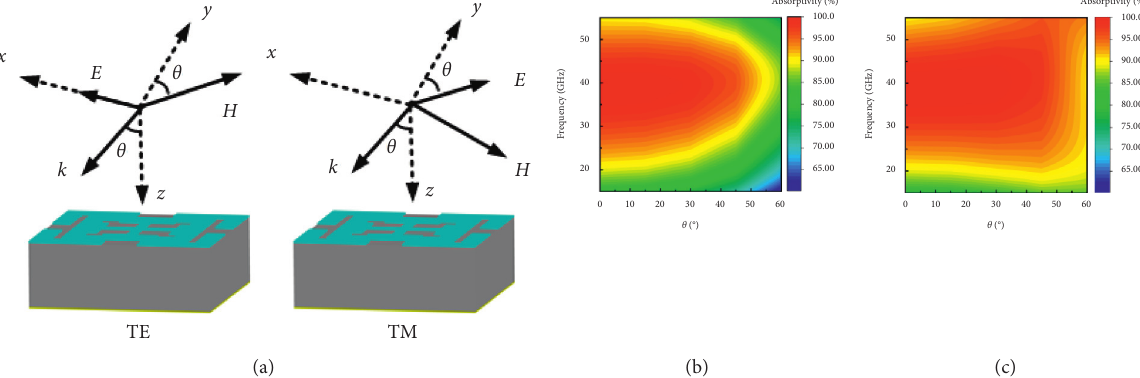
Figure 7: (a) Schematic view of the proposed absorber at oblique incidences, (b) absorptivity of TE polarization at different incident angle, and (c) absorptivity of TM polarization at different incident angle.